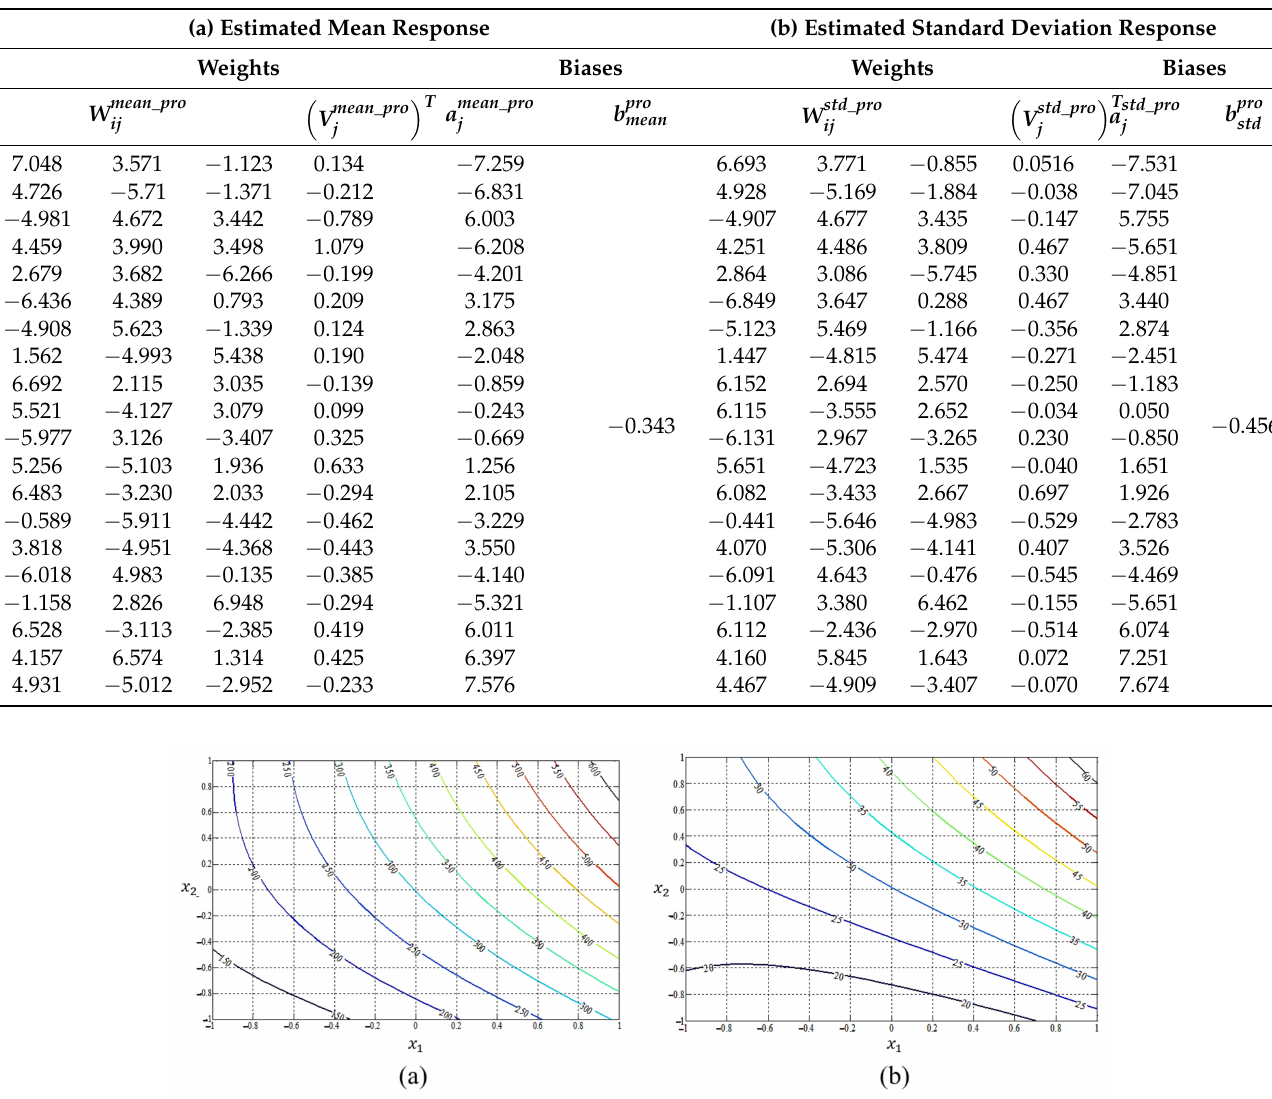
Figure 4. Estimated process mean and standard deviation response functions from the conventional LSM approach based on RSM: ( a ) mean ( R 2 = 92.68%); ( b ) standard deviation ( R 2 = 45.42%).